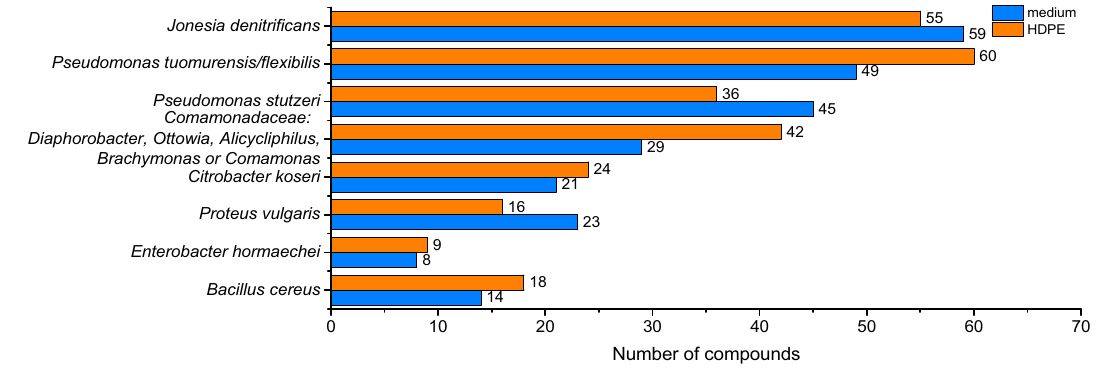
Fig. 4 Number of compounds detected in the medium (blue column) and organic matters around the surface of HDPE (orange column) after degradation with all tested bacterial